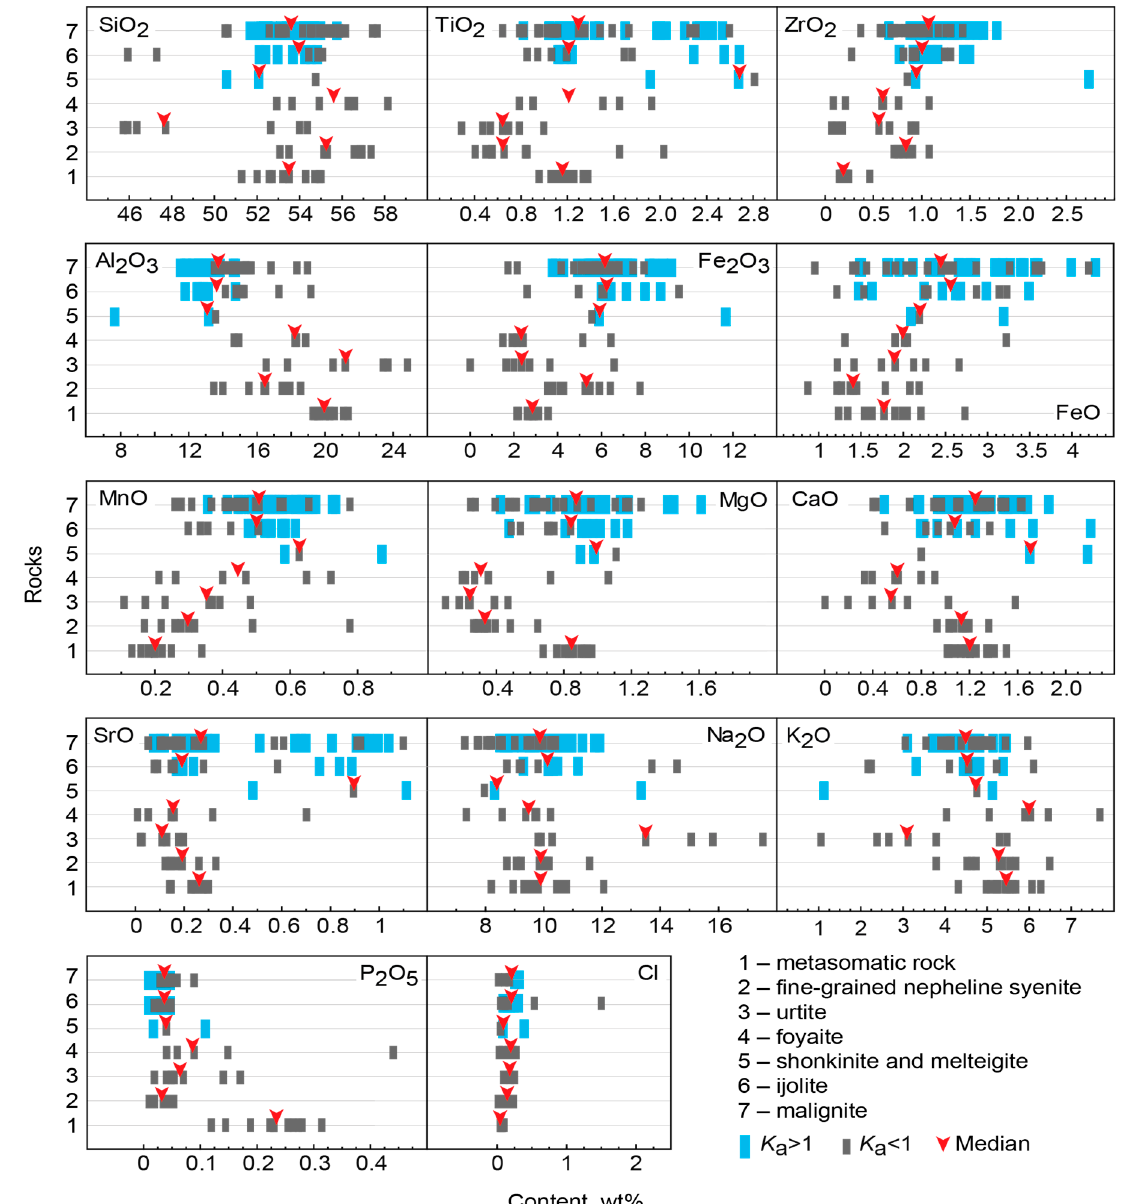
Figure 6. Variations in the chemical composition of rocks of the Alluaiv site. The rocks are divided into two groups by the value K a = (Na 2 O + K 2 O)/Al 2 O 3 . Red arrows show the median contents.